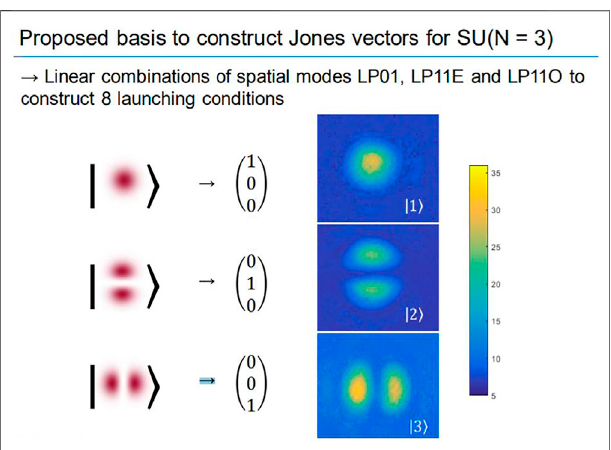
FIGURE5| The eigen modesofthe fi ber tobesuperimposed inorderto determine the Principal Modes.